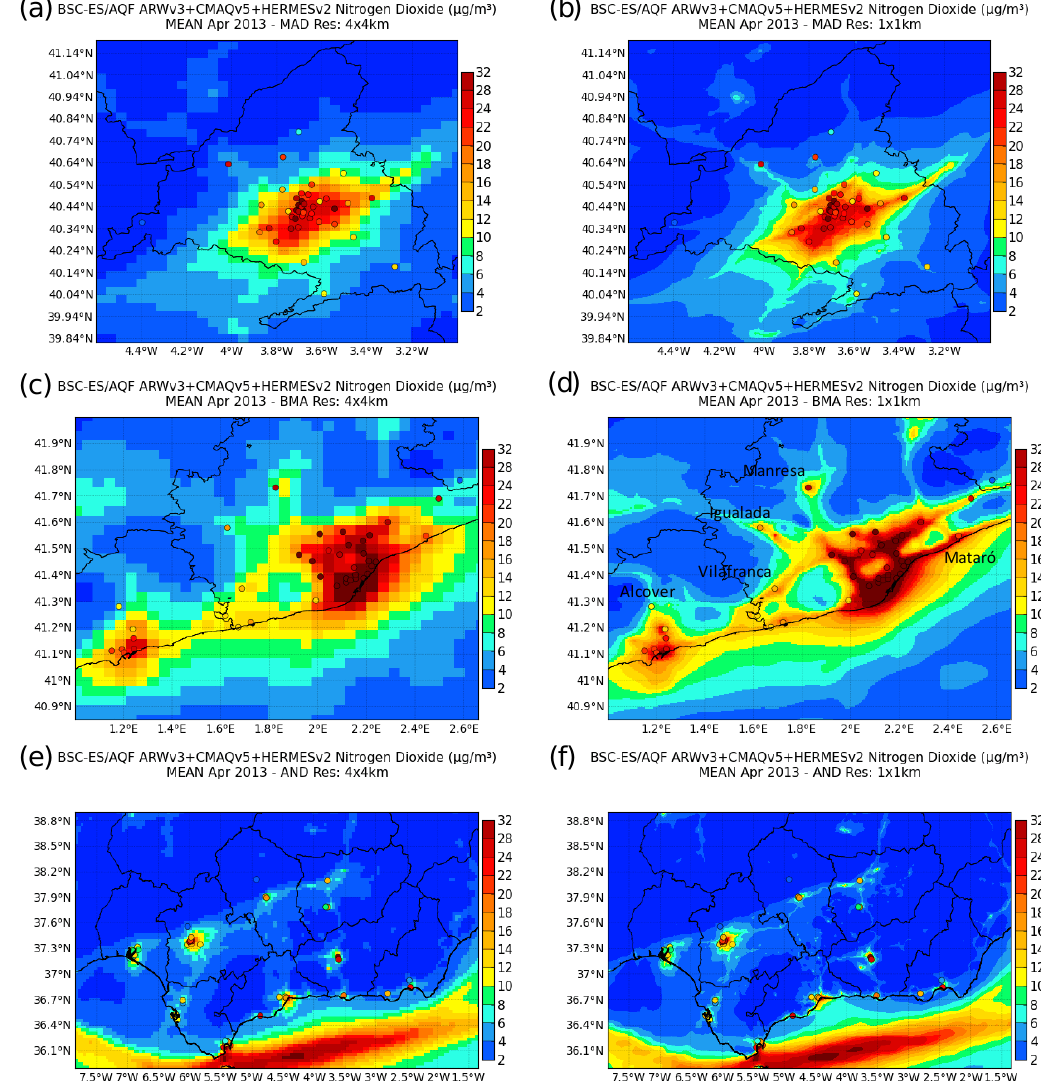
Figure 3. CALIOPE-AQFS mean NO 2 concentrations (µgm − 3 ) in April 2013 over (a, b) MAD, (c, d) BCN, and (e, f) AND, as a function of horizontal resolution: 4km (left column) and 1km (right column). Dots indicate the mean concentrations at the air quality